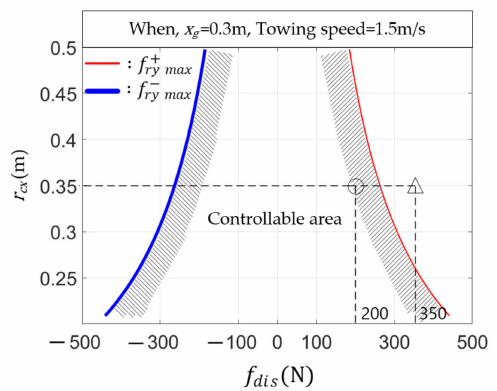
Figure 14. Two points (positions of towing point and disturbances) selected for yaw control simula- tion (marked with a circle and triangle, respectively).